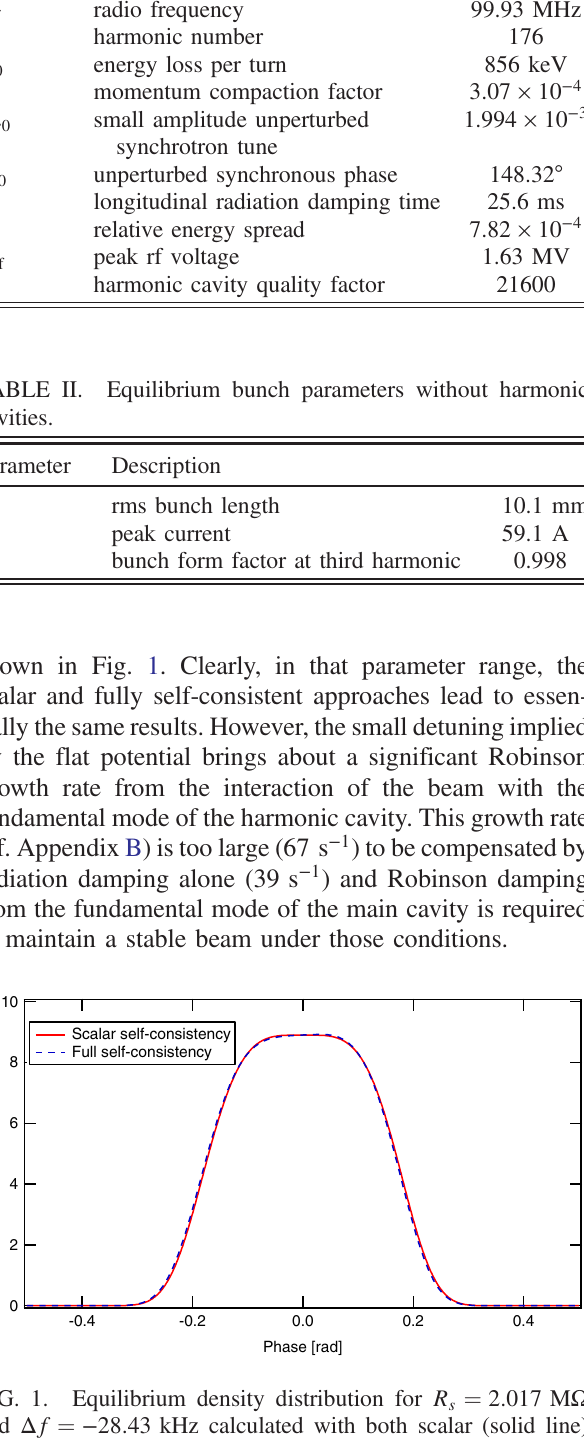
FIG. 1. Equilibrium density distribution for R and Δ f ¼ − 28 . 43 kHz calculated with both scalar (solid line) and fully self-consistent (dashed line) approaches. The rms bunch length is 54.1